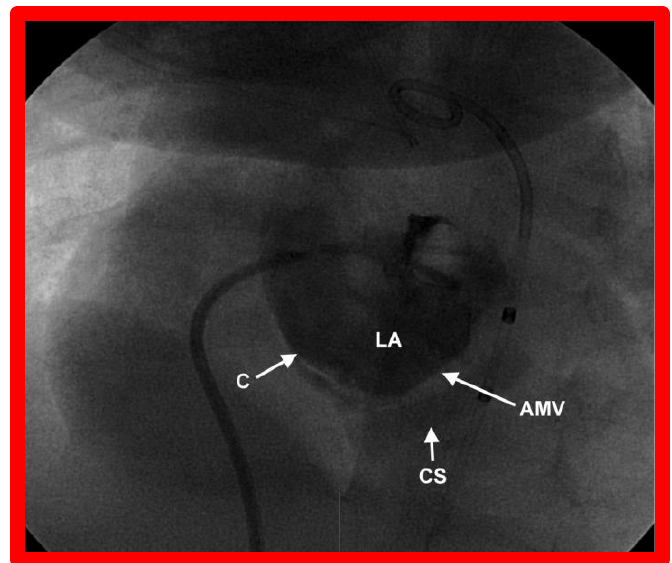
Figure 5. A selected cine frame from a cine-angiogram of the left atrium (LA) illustrates the position of the restricted atrial septum (arrow) and a markedly dilated pulmonary vein (PV). Sternal wires from prior surgery are seen, but not labeled. RA, right atrium. Modified from [7].